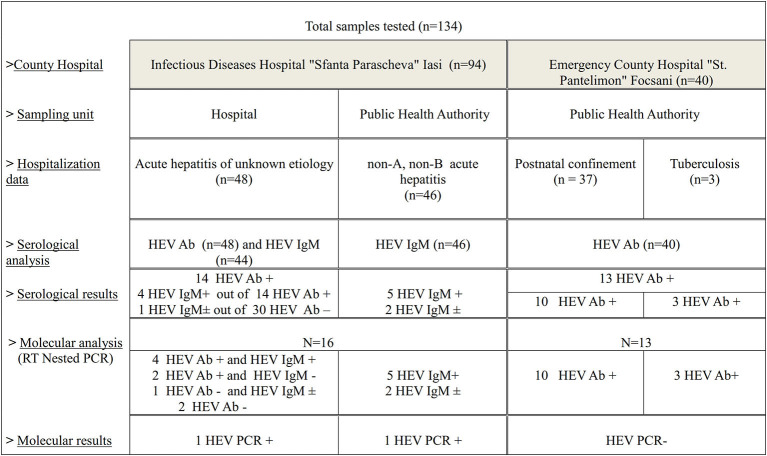
Diagram of the study flow chart.